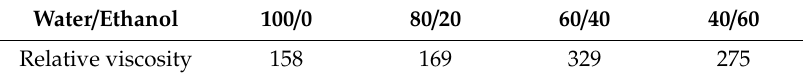
Table 1. Relative viscosity of PECs in different water/ethanol ratio.